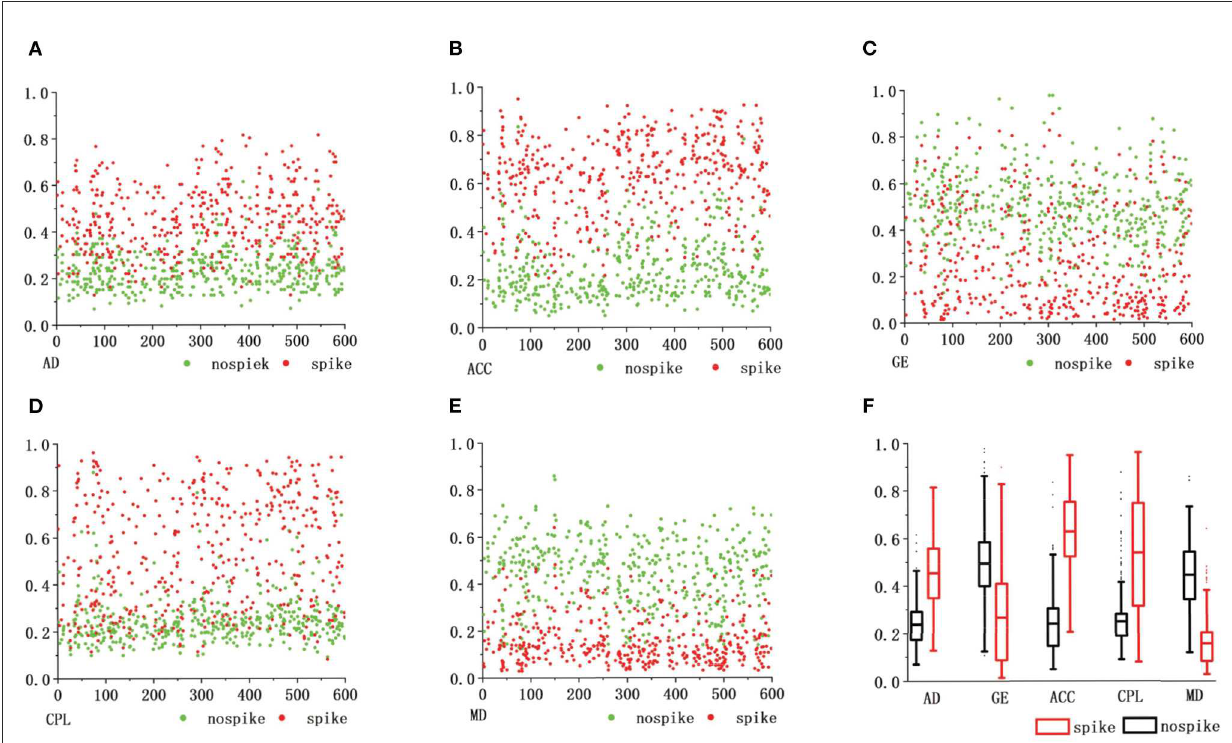
FIGURE6 The abscissa of the comparison of functional brain network features. (A–E) Represents the recording time, the ordinate represents different functional brain network features, and the red dots represent the spike discharge and the corresponding FBN-PLV eigenvalues in this epoch. The green dots represent FPS discharge and the corresponding FBN-PLV eigenvalue in this epoch. The (F) is a comprehensive comparison of weighted network topology attributes.